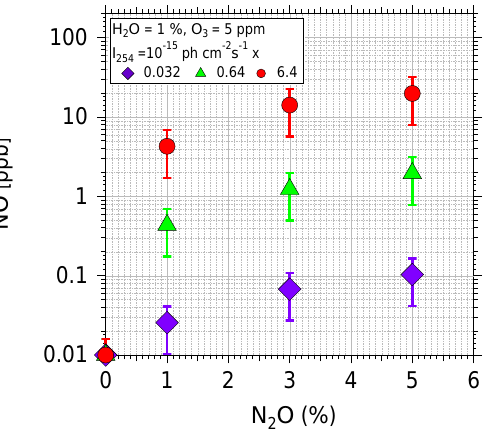
Figure 3. Modeled steady-state [NO] as a function of [N 2 O] in- put to the PAM reactor at I 254 = 0.032 × 10 15 , 0.64 × 10 15 , and 6.4 × 10 15 phcm − 2 s; [H 2 O] = 1%; [O 3 ] = 5ppm; and mean res- idence time = 80s. Error bars represent ± 60% uncertainty in mod- eled [NO] (Peng et al.,